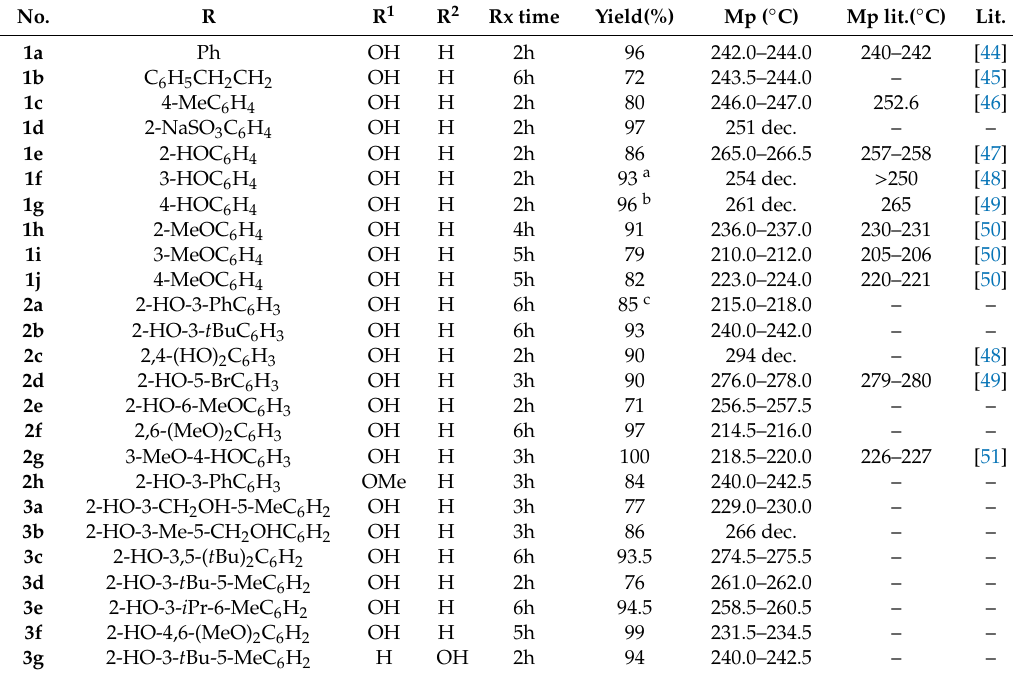
Table 1. Characteristics of hydrazide-hydrazones 1a–j , 2a–h , and 3a–g